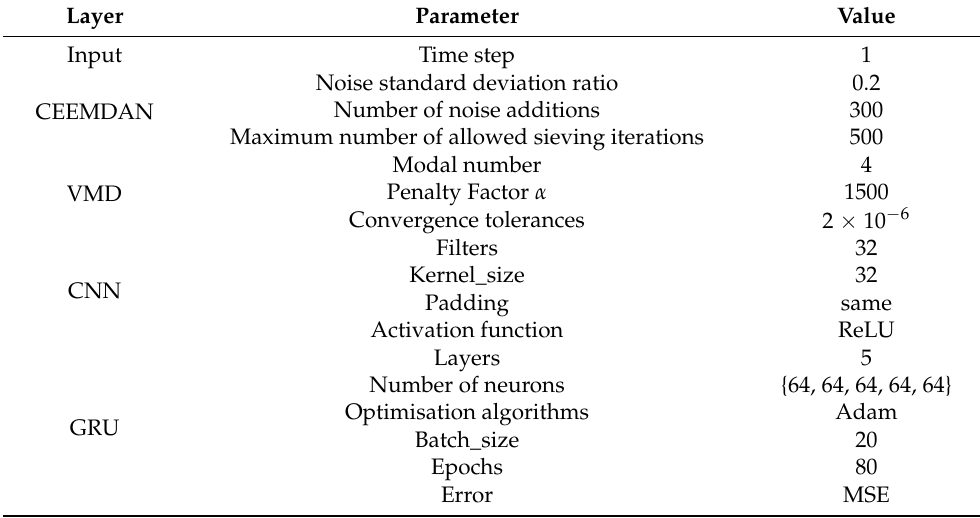
Table 1. Main parameters of the